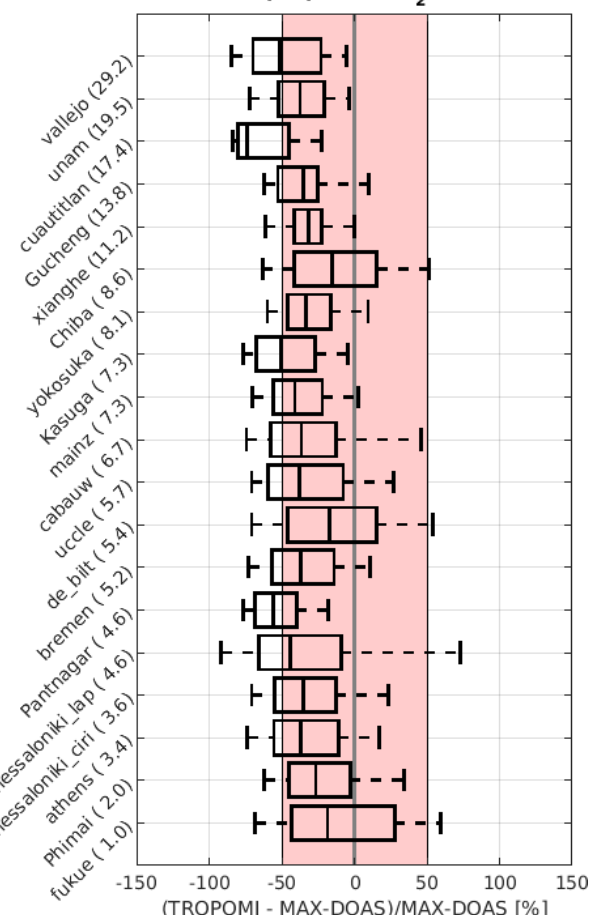
Figure 10. Same as Fig. 6 but now for the difference between S5P TROPOMI OFFL and MAX-DOAS NO 2 tropospheric columns and ordered as a function of the median ground-based tropospheric col- umn (largest median VCD values on top). The line represents the median difference. Box bounds represent the 25 and 75 percentiles, while whiskers indicate the 9 and 91 percentiles. The shaded area corresponds to the mission requirement of a maximum bias of